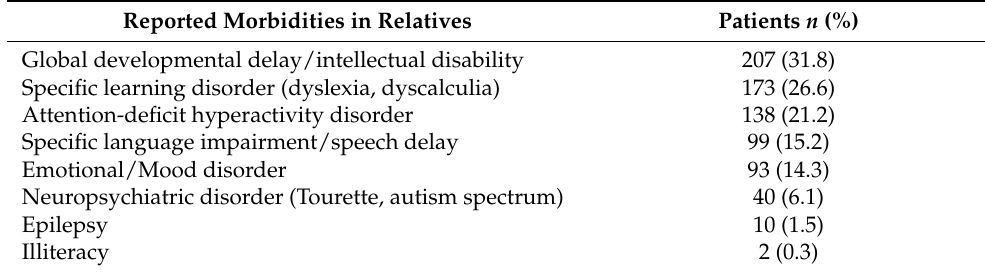
Table 2. Reported neurological or neuropsychiatric morbidities in the near relatives of 651 study patients, many having more than one of these hereditary predispositions in the